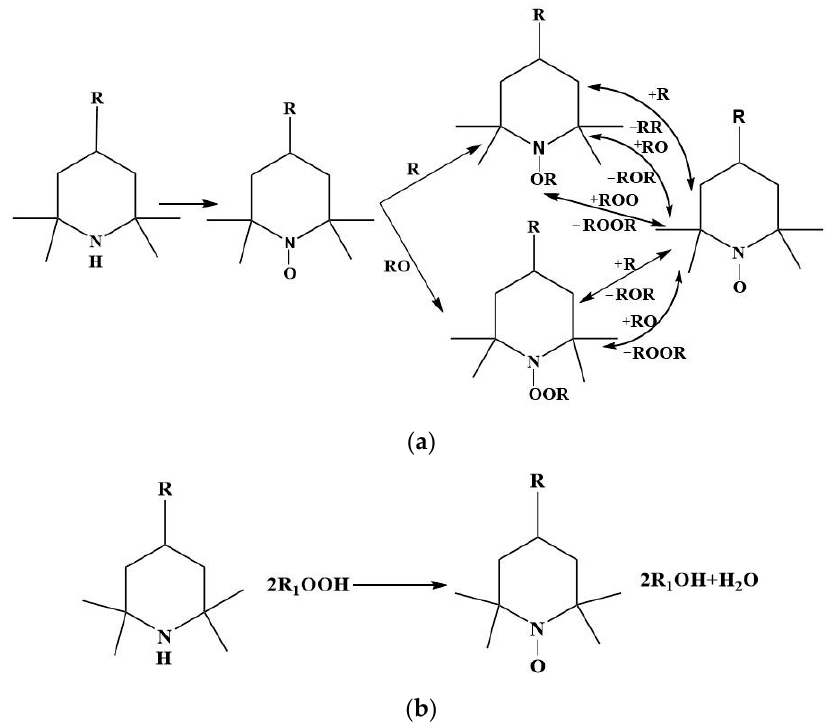
Figure 8. ( a ) The action mechanism of HALS capturing free radicals; ( b ) The mechanism of HALS in peroxide decomposition.